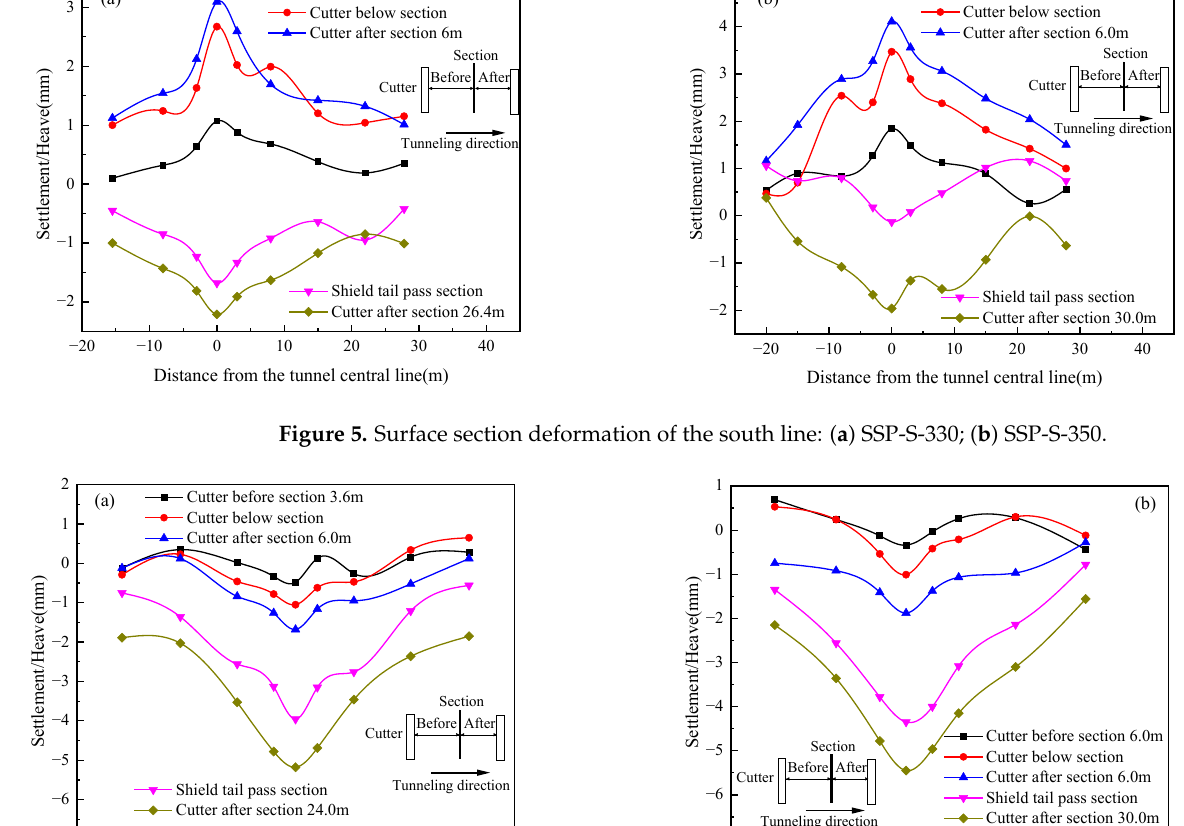
Table 2. Proportion of surface deformation during construction of the south line.